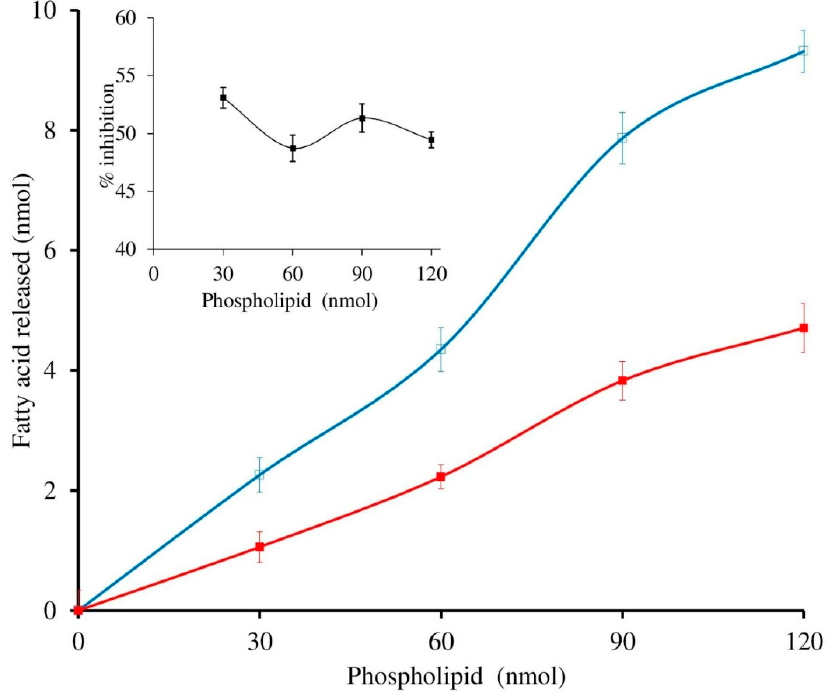
Figure 5. Effect of substrate concentration on sPLA2-IIA inhibition: The sPLA2 IIA activity was measured with the substrate concentrations ranging from 30 to 120 µL with ( ■ ) and without ( □ ) IC 50 concentration of sinapic acid. The sPLA 2 -IIA inhibition is shown in the inlet. The data are expressed as mean ± standard deviation (n = 3).